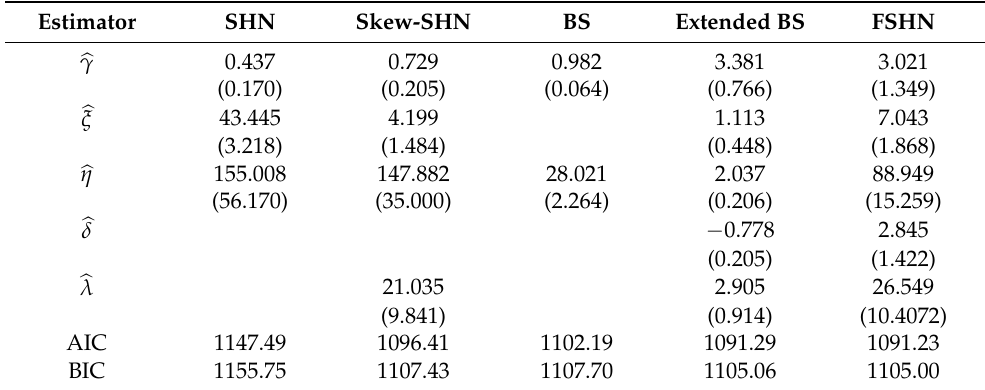
Table 1. Estimates of parameters and their standard errors in parentheses for sinh-Normal (SHN), skew-SHN, BS, extended BS and FSHN